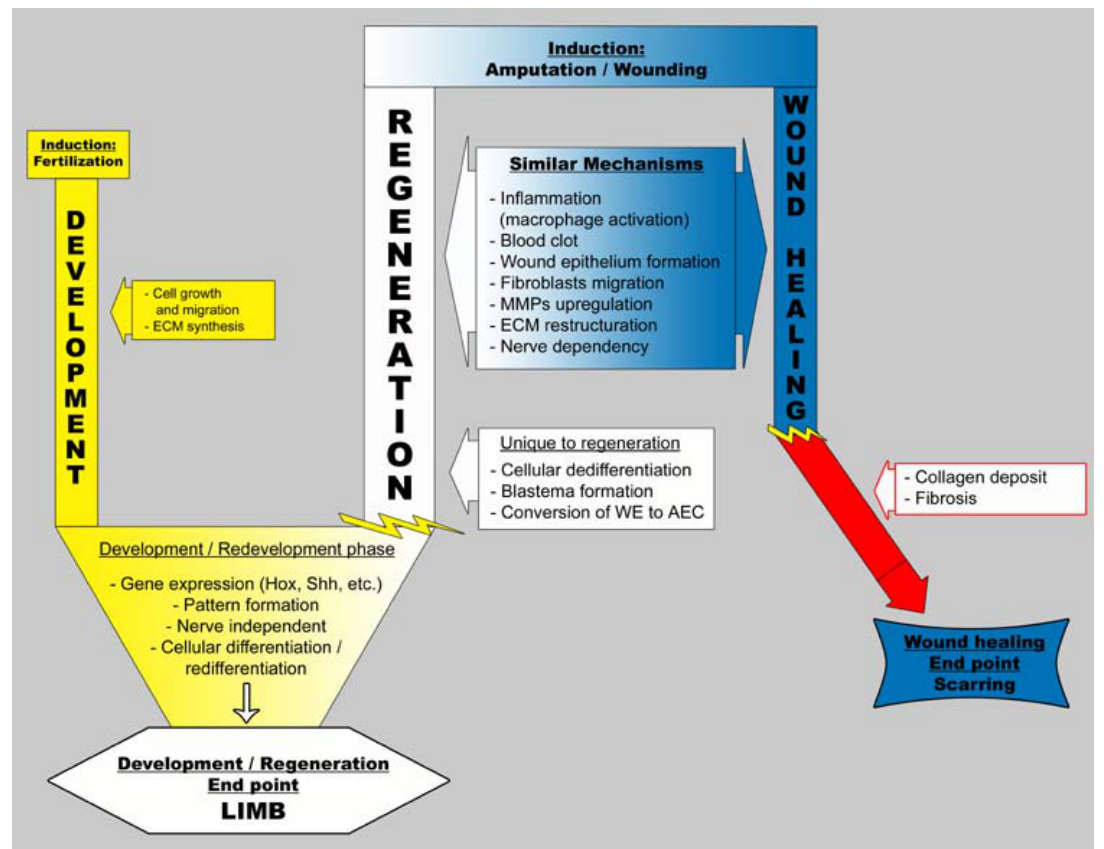
FIGURE 1. Parallels between development, wound healing, and regeneration. Regeneration is a biphasic phenomenon with a preparation phase and a redevelopment phase. The preparation phase displays many mechanisms that share similarities to those observed during the earlier part of wound healing. The redevelopment phase, as its name indicates, shares many similarities with development. The appearance of the AEC, cellular dedifferentiation, and blastema formation represent processes that are entirely unique to